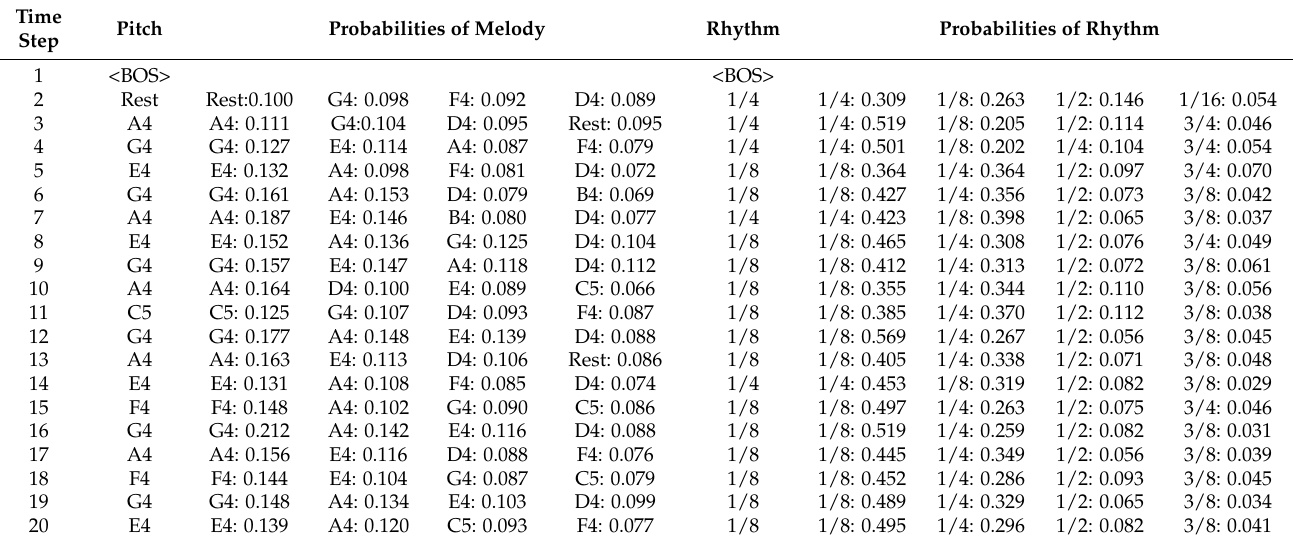
Table 2. Details of autoregressive generation.